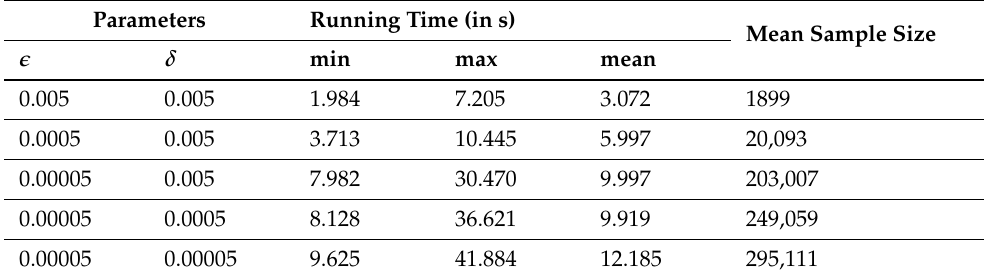
Table 1. Dyck 1: Probably approximately correct (PAC) deterministic finite automata (DFA) extraction from recurrent neural networks